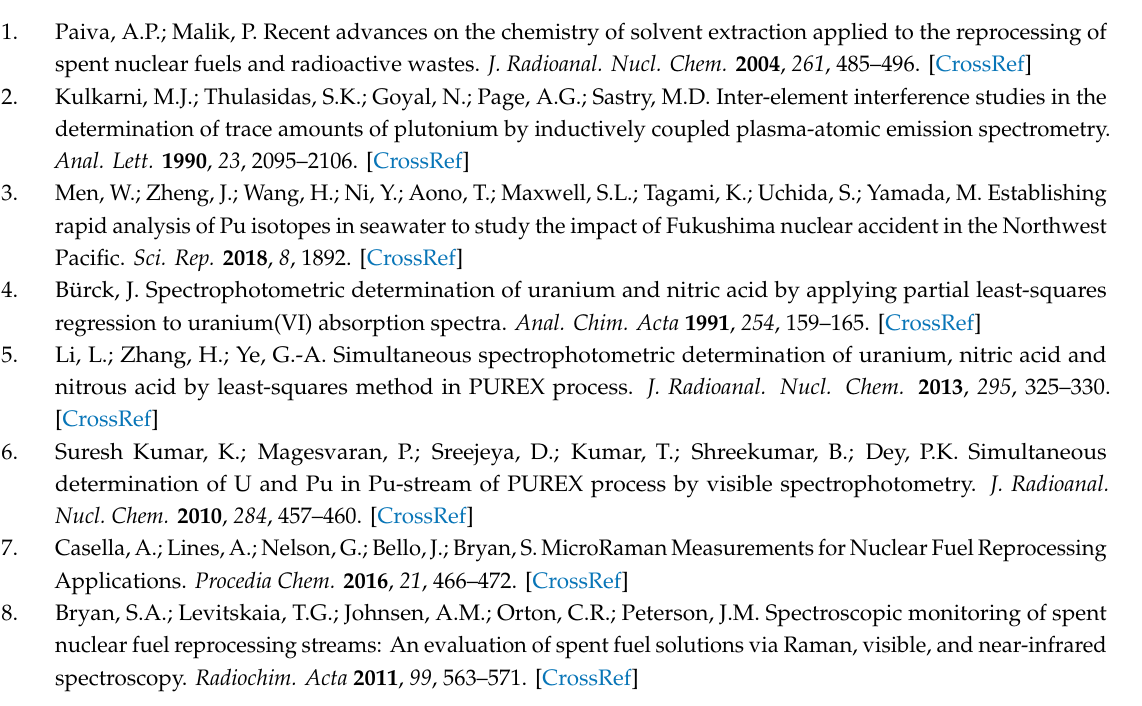
Table S1: List of sensors ligands; Table S2: lg K(Pu 4 + / Me n + ) selectivity values of the sensors for selected actinides and lanthanides; Figure S1: Visual appearance of the developed sensor array; Figure S2: Sensitivity to Pu 4 + in the presence of 500 mg / L uranium; Figure S3: Sensor responses in the simulated PUREX